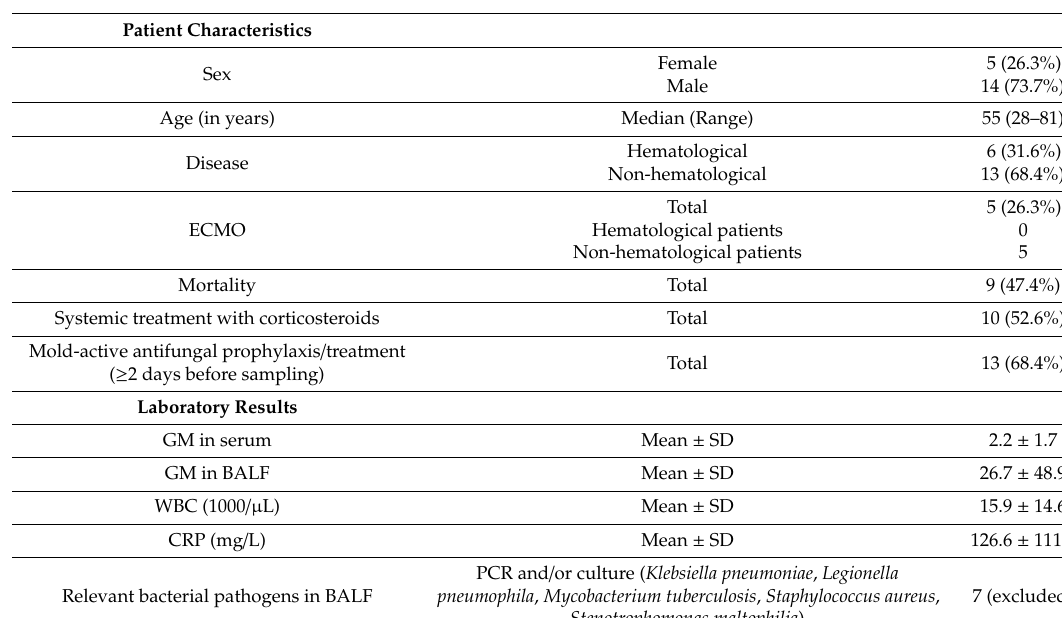
Table 1. Characteristics of IPA patients.